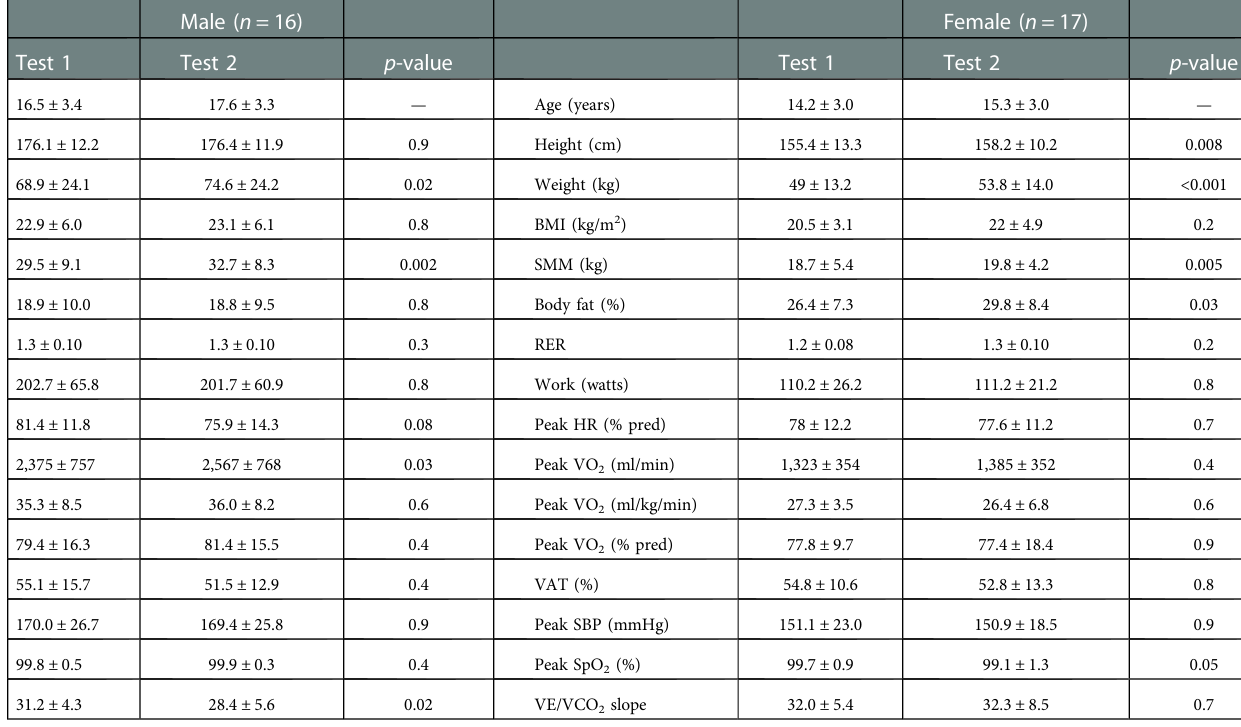
TABLE 3 Differences in anthropometric and exercise testing data by sex in the pediatric and congenital heart disease patients tested before and during the COVID-19